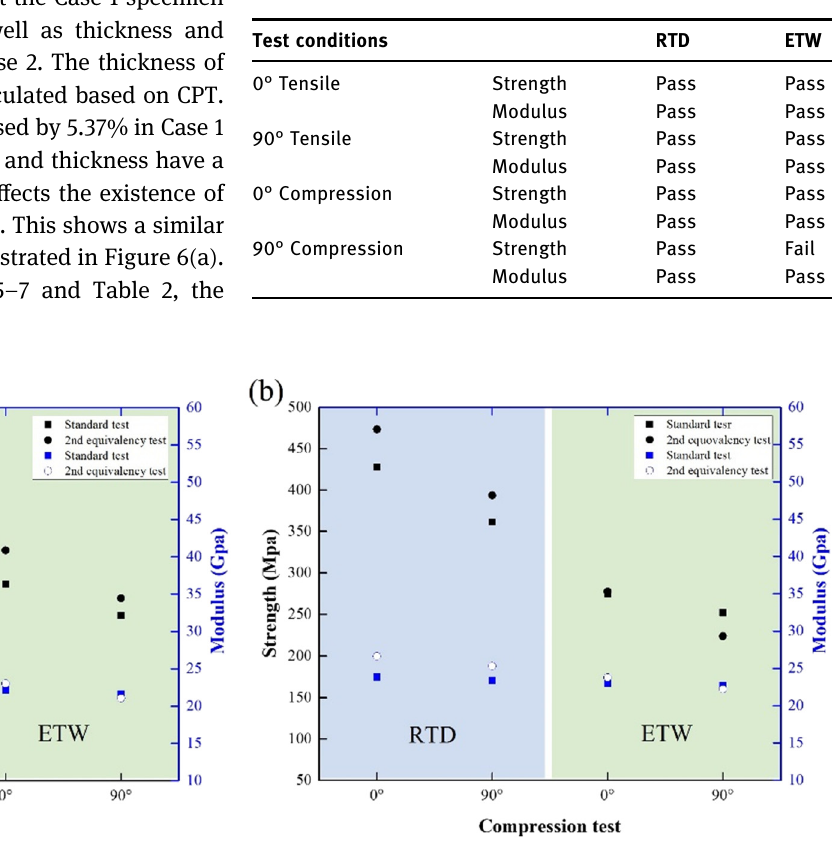
Figure 8: The result of second equivalency test: ( a ) tensile and ( b ) compression test.